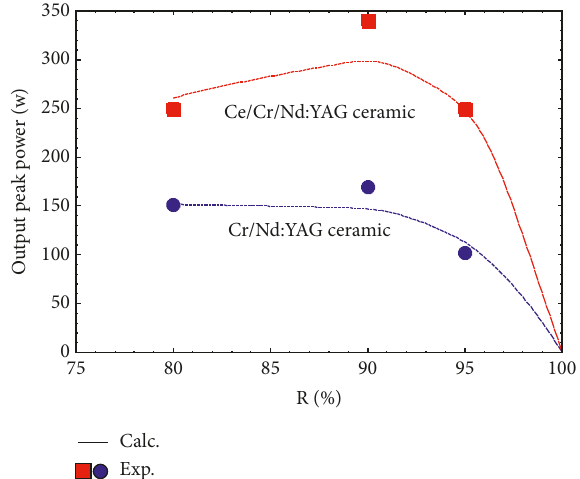
Figure 12: Dependence of mirror reflectivity on output laser peak